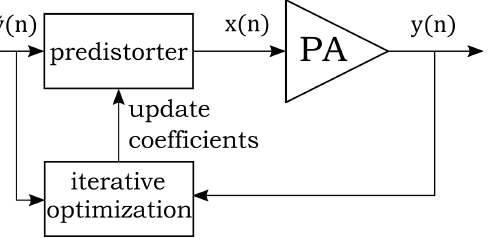
Figure 3. Block diagram for DLA-based DPD using an iterative nonlinear